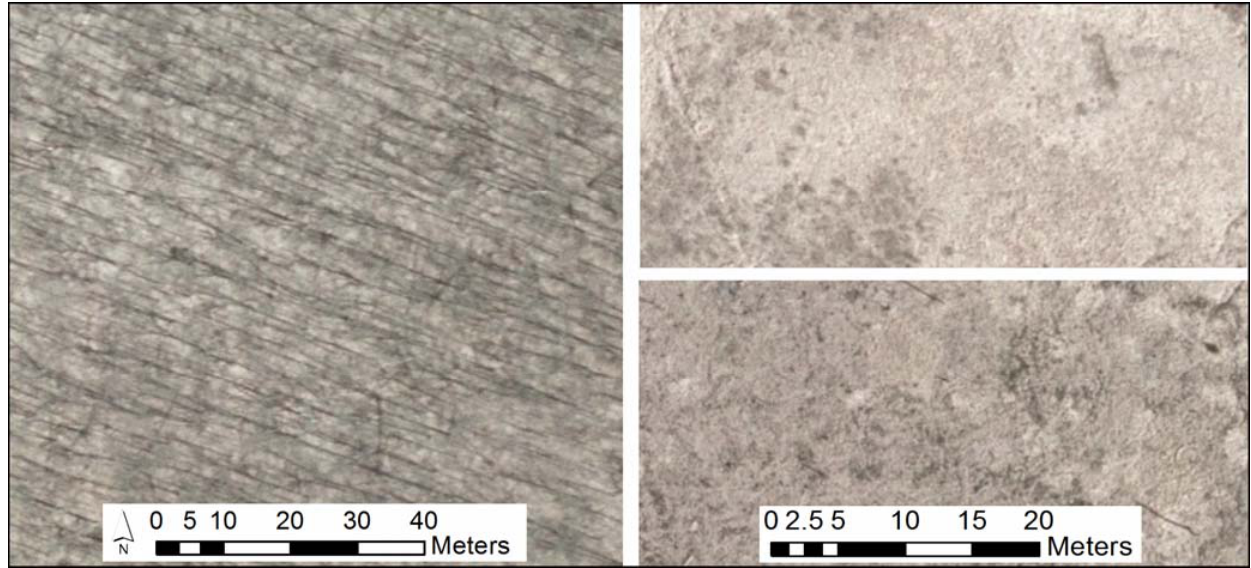
Figure 6. Leaf-off orthophoto examples of deciduous forest (left) and examples of two extensive sections of senescent wetland vegetation that border open water sections of wetlands or